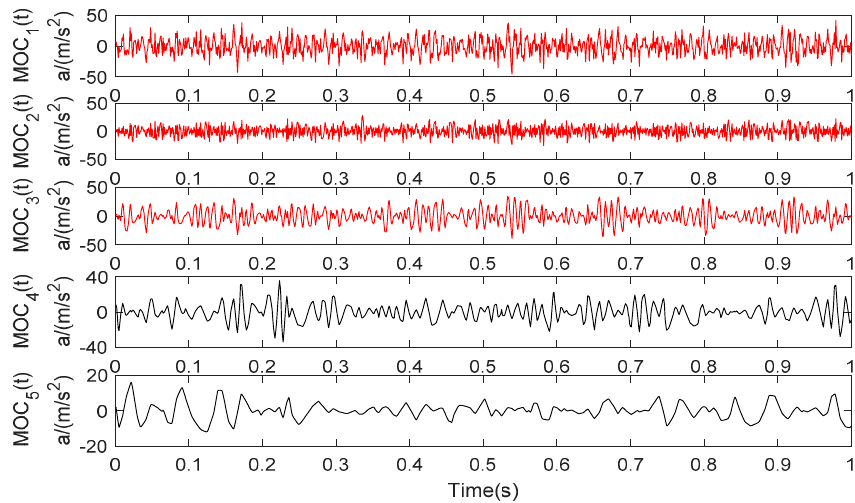
Figure 19. RS-LOD decomposition results of the fan gearbox vibration acceleration signal ( p = 9).